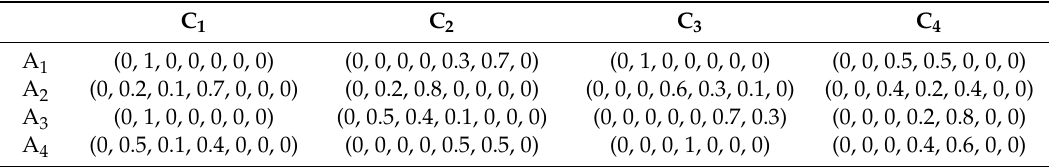
Table 7. Possibility distribution hesitant fuzzy linguistic decision matrix by expert E 4